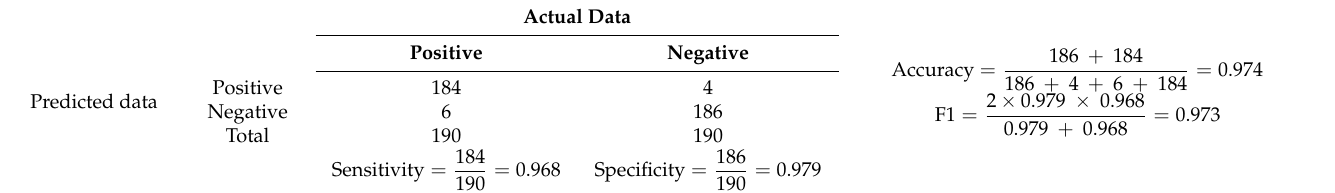
Table 3. A confusion matrix obtained from the random forest algorithm for the classification of CIEP in mink.